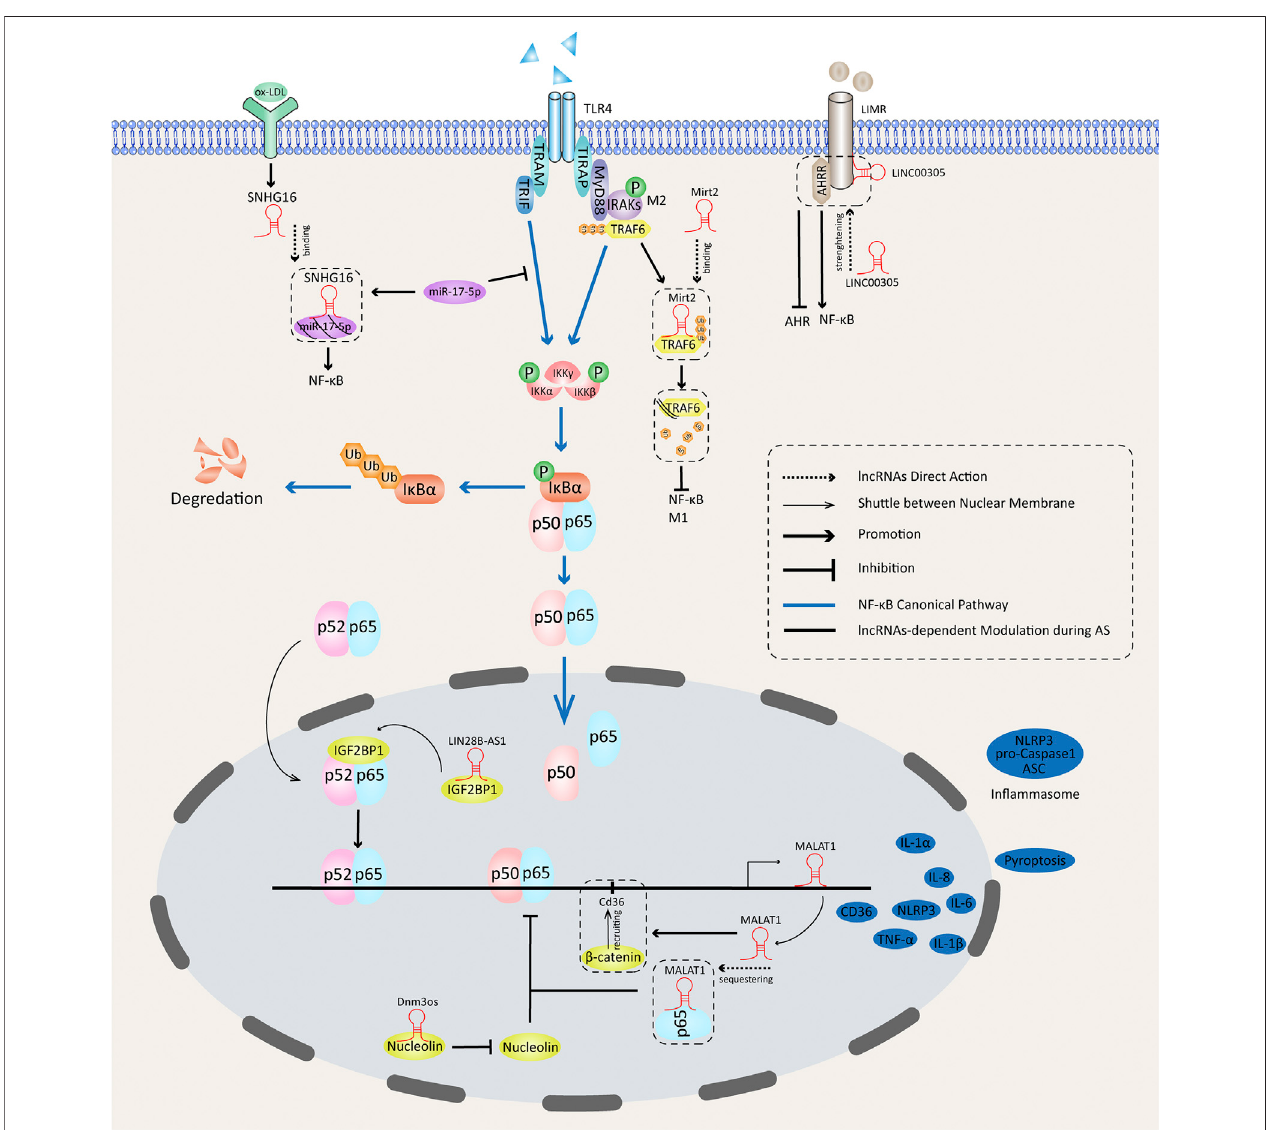
FIGURE 1 | Functions of NF- κ B – dependent lncRNAs in atherosclerotic in fl ammation.